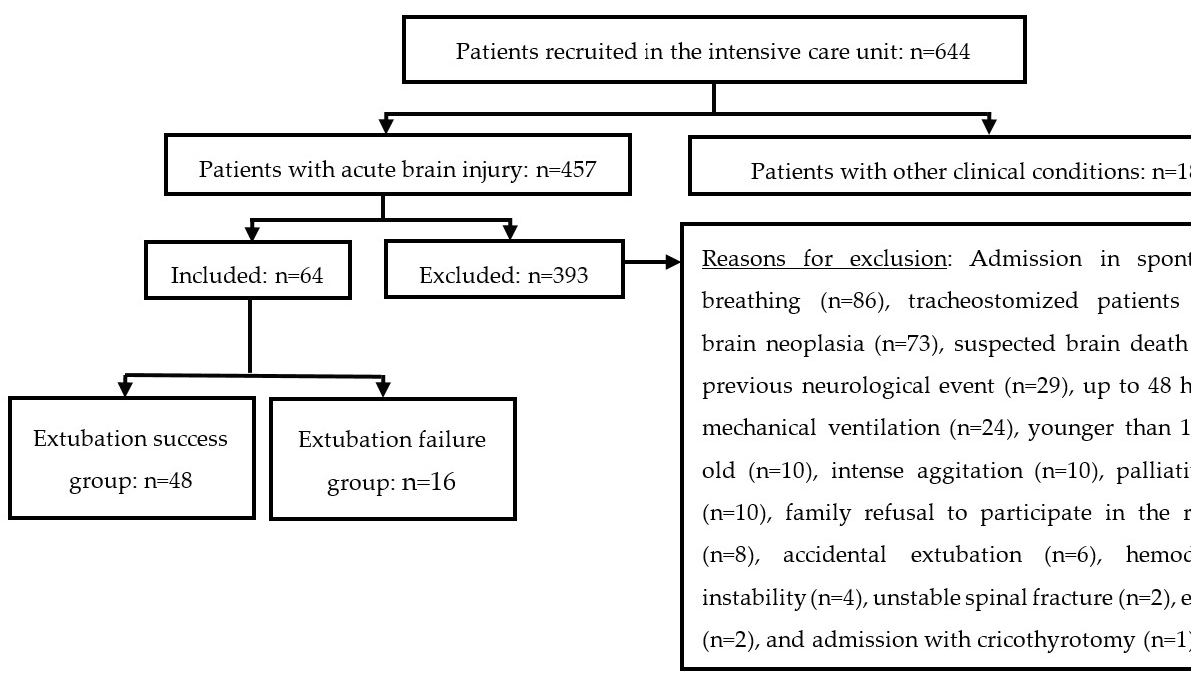
Figure 1. Flowchart of selection of participants.